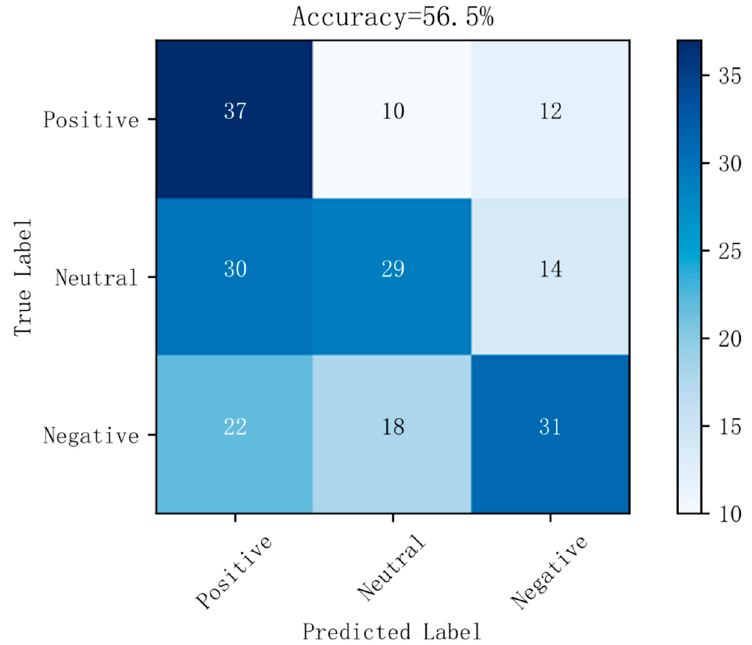
Figure 7. Confusion matrix in original dataset based on LDA with RF.